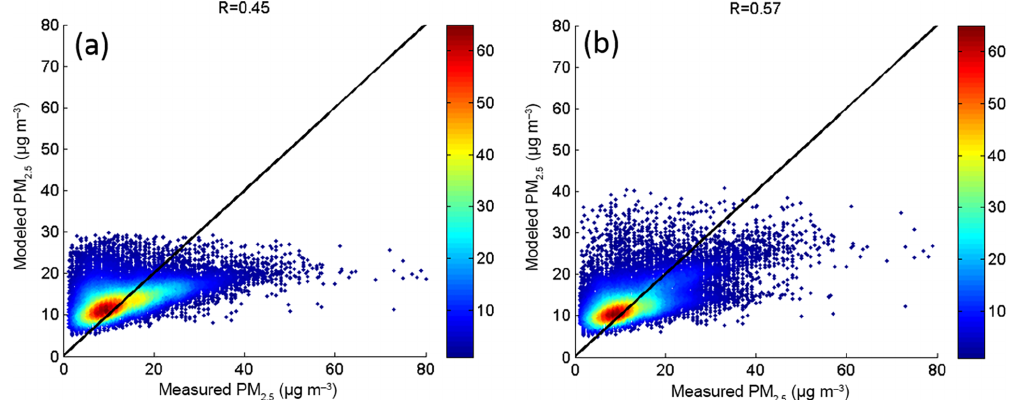
Figure 9. Comparison of measured PM2.5 and modeled PM2.5 when meteorological variables are not taken into account. (a) The model is non-seasonally fitted, and (b) the model is seasonally fitted. The colors stand for the number density of the points.